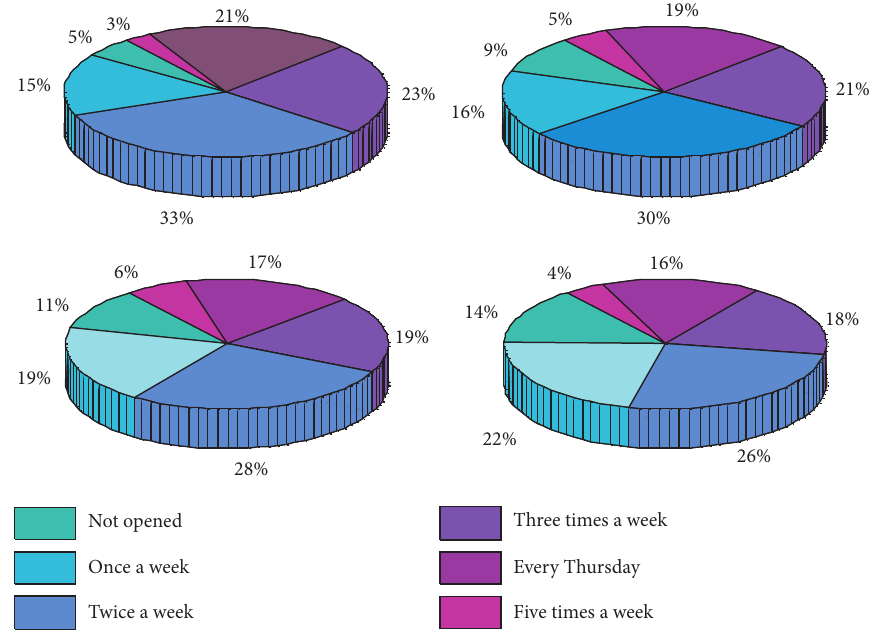
Figure 4: Proportion of football class hours in physical education in four